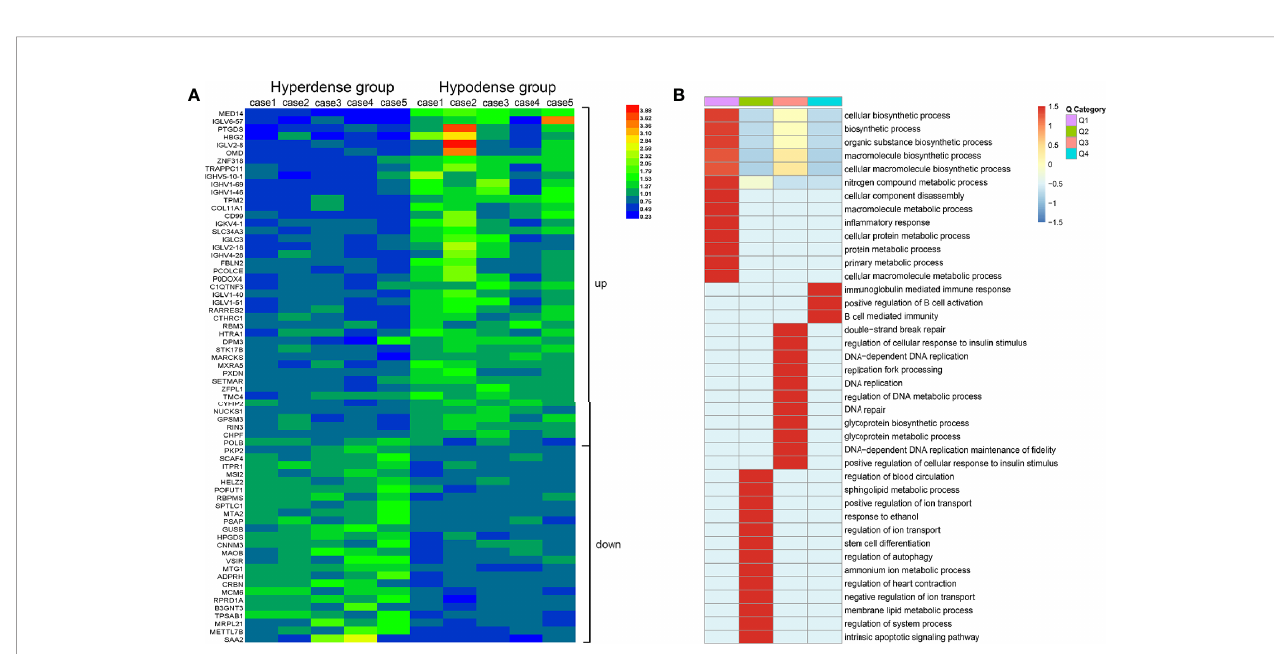
FIGURE 5 | Total protein TMT labeling was used to quantify the proteomes of pancreatic cancer tissue samples. (A) Differential protein expression between hyperdense patients and hypodense patients. (B) Heat map of cluster analysis based on GO classi fi